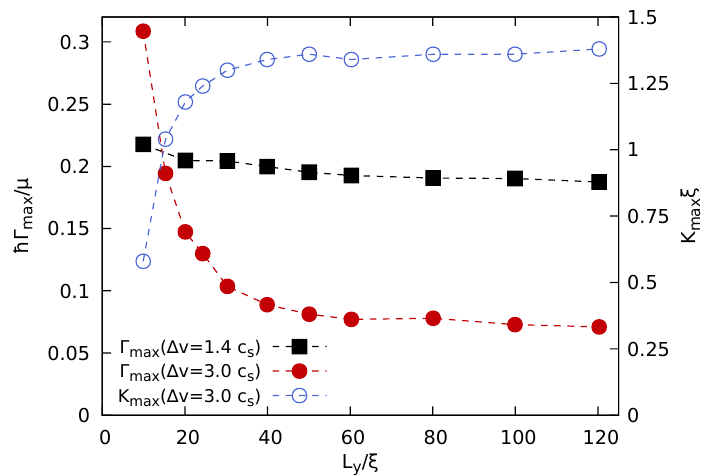
= max ( Im ( ω )) on the Figure 4: Dependence of the maximum instability rate Γ max system size L for ∆ v = 1.4 c in the KHI regime (black squares) and for ∆ v = 3 c in y s s the SRI / RI regime (filled red circles); empty blue circles show the K -space location = argmax ( Im ( ω )) in the second ∆ v = 3 c of the most unstable mode K case ( y max s K axis on the